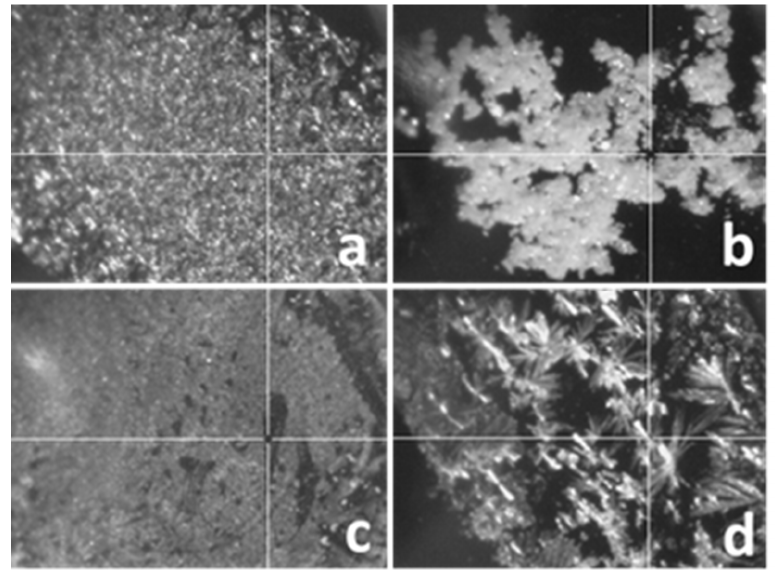
Figure 4. MALDI camera images of the pre-dose human urine samples spiked with PEG 400 depos- ited on the MALDI target plate using various matrices: ( a ) DHB; ( b ) DCTB; ( c ) Dithranol; ( d ) THAP (magnification: